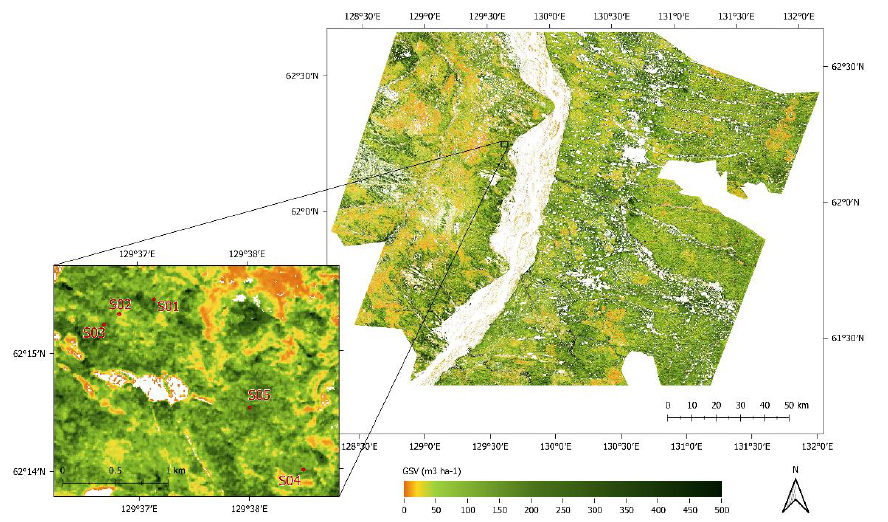
Figure 7. Modelled forest GSV in Sakha. The inset shows the area around the Spasskaya Pad field station, which includes five field plots.